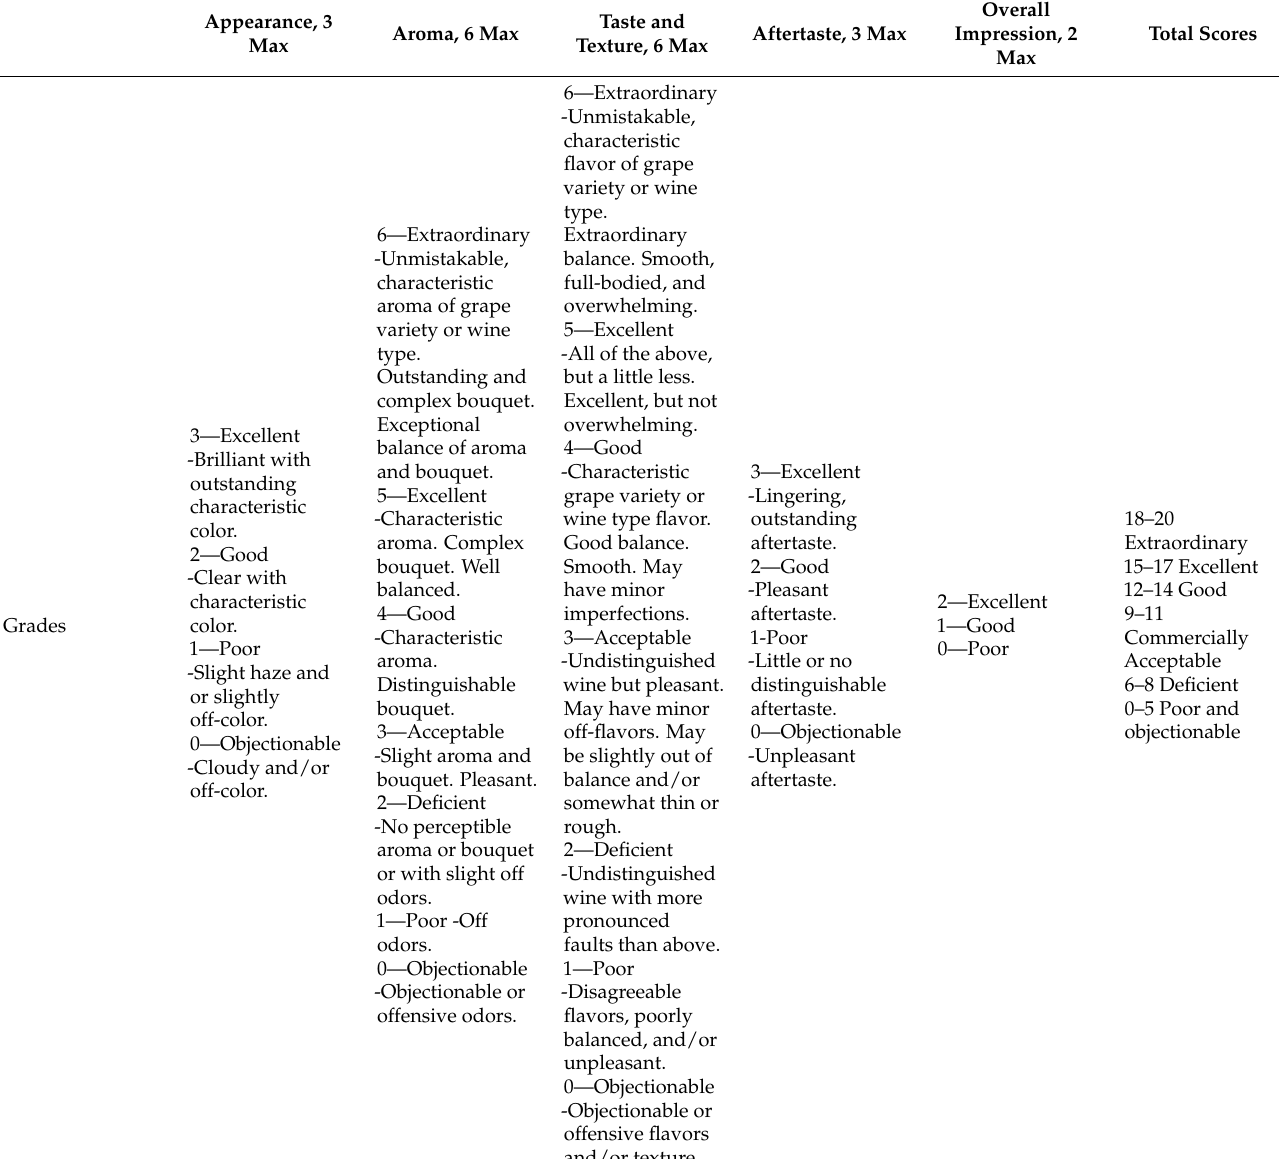
Table 2. Evaluation of sensory